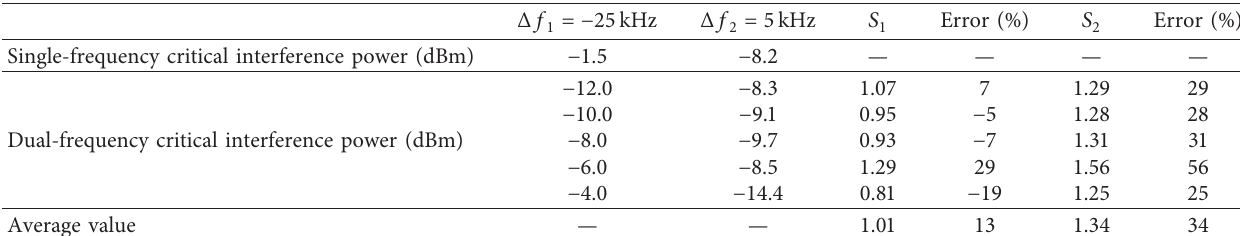
Table 4: Critical interference power when the communication station is working at